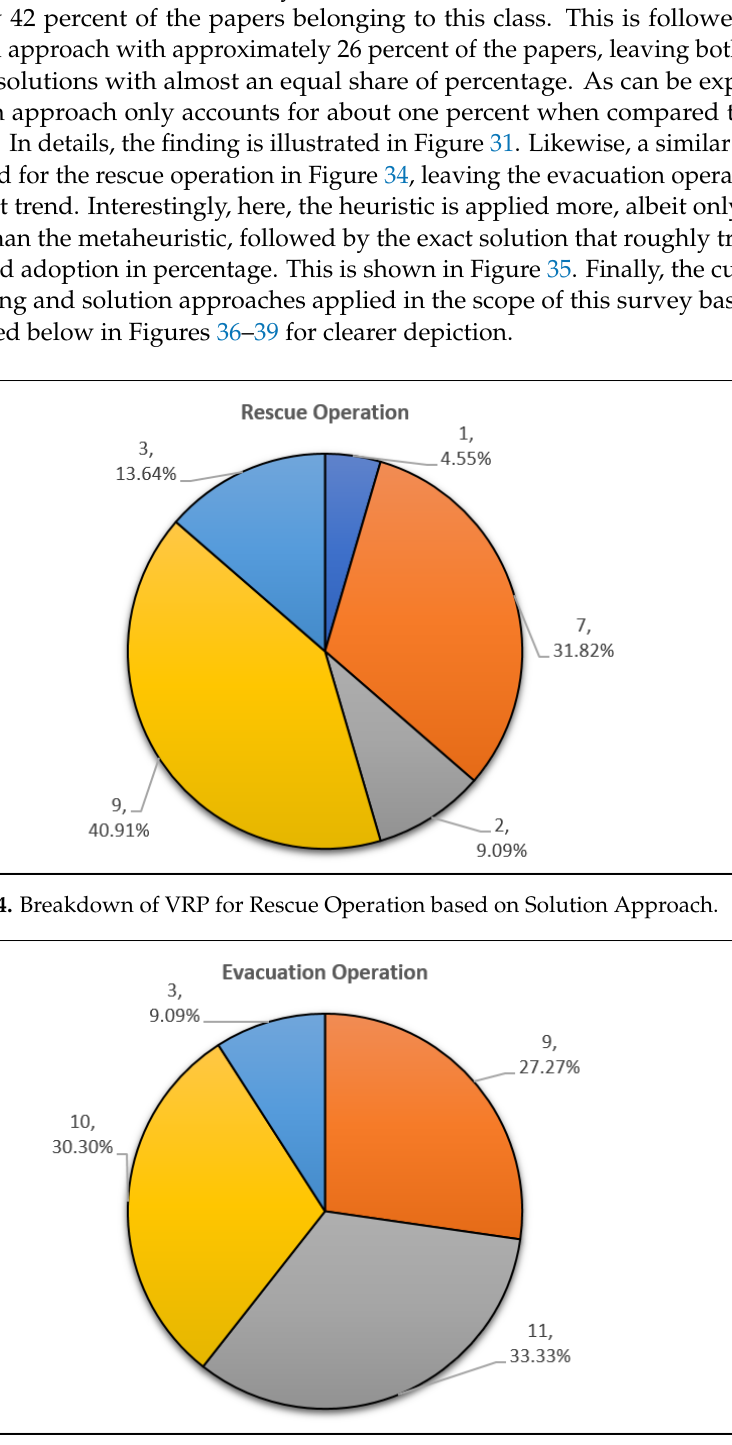
Figure 35. Breakdown of VRP for Evacuation Operation based on Solution